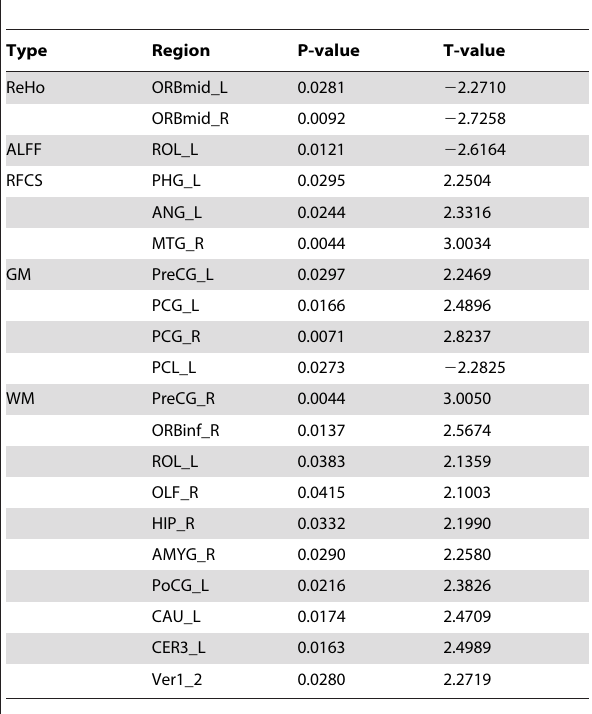
Table 5. The brain regions which have been selected as features more than 23